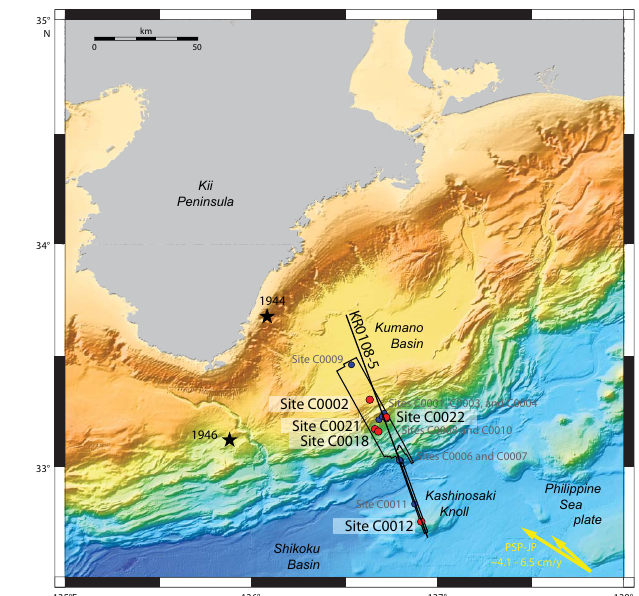
Figure 1. Map of the NanTroSEIZE region showing all Stage 1, 2, and 3 drill sites. Red = Expedition 338 sites, blue = NanTroSEIZE Stage 1 and 2 sites. Black outline = region with 3-D seismic data, yellow arrows = estimated far-field vectors for motion of Philippine Sea Plate (PSP) with respect to Japan (JP) (Seno et al., 1993; Heki, 2007). Stars = epicenter locations of 1944 and 1946 tsunamigenic earthquakes. Black line = KR0108-5 seismic reflection line shown in Fig.